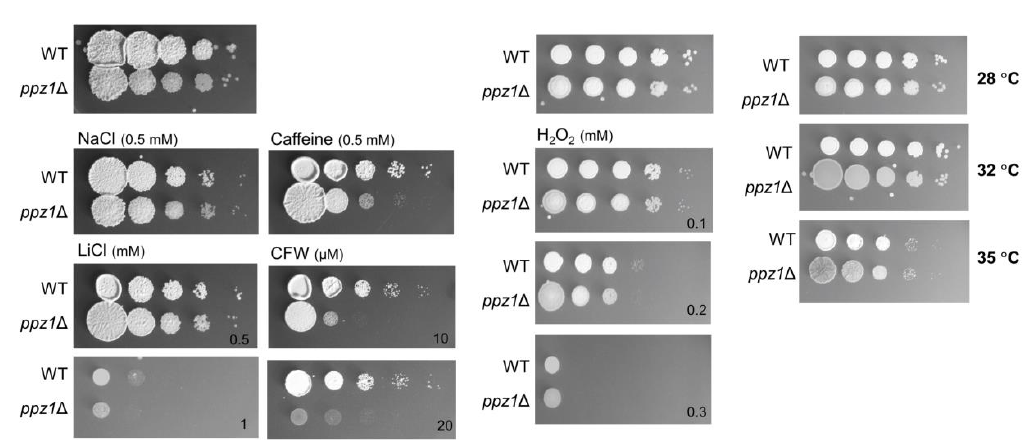
Figure 7. Phenotypic analysis of the U. maydis UmPpz1 mutant. Wild type (WT) and UmPpz1-deficient cells ( ppz1 ∆ ) were grown in YPD and ten-fold dilutions of this culture were spotted on CMD plates with the indicated chemicals. Cells were incubated for two days at 28 ◦ C. For temperature sensitivity, CMD plates were incubated for two days at the indicated temperature.